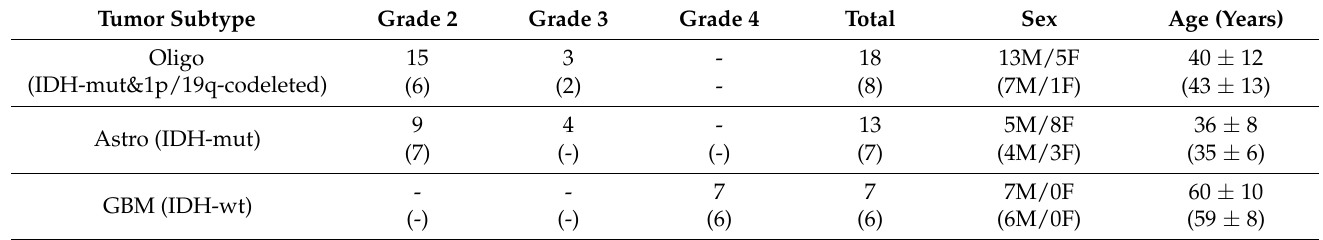
Table 1. Patient characteristics and histopathological grade based on the WHO 2021 classification of tumors of the central nervous system [6]. Patient characteristics with additional histopathological tissue analysis in